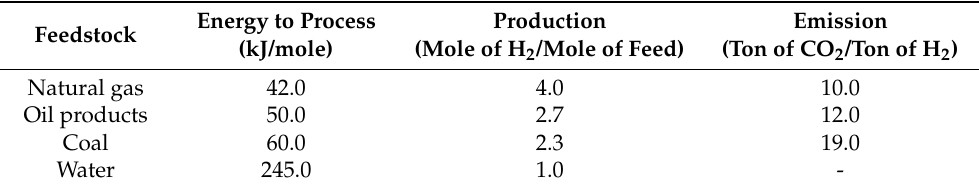
Table 2. Comparison of hydrogen production based on the source of feedstock and amount of energy to process. Energy to